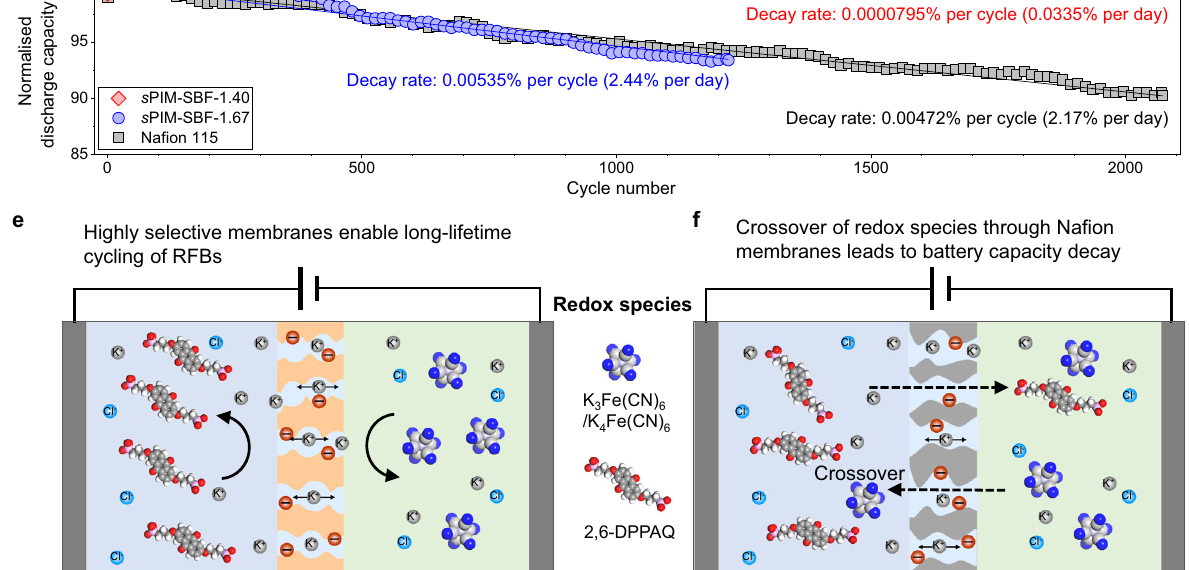
Fig. 4 Low-concentration redox fl ow battery performance. a EIS spectra of K 4 Fe(CN) 6 (0.1 M)|2,6-DPPAQ (0.1 M) fl ow battery cells at 100% SOC. b Energy ef fi ciency as a function of current density in the range of 10 – 100 mA cm − 2 . Membrane thicknesses are 142 µ m (Na fi on 115), 176 µ m ( s PIM-SBF- 1.86), 45 µ m ( s PIM-SBF-1.67a), 177 µ m ( s PIM-SBF-1.67b), 134 µ m ( s PIM-SBF-1.40) and 139 µ m ( s PIM-SBF-0.98), respectively. c Voltage and power density versus current density at ~100% SOC. d Cycling stability of K 4 Fe(CN) 6 (0.1 M)|2,6-DPPAQ (0.1 M) RFBs assembled with s PIM-SBF-1.40 (134 µ m), s PIM- SBF-1.67 (177 µ m) and Na fi on 115 membranes at pH 9 and a current density of 100 mA cm − 2 . Normalized discharge capacity data are linearly fi tted to derive capacity decay rates. The operating temperature in the glovebox is around 30 °C. Schematic illustrating the crossover mechanism that dominates battery capacity decay based on e , s PIM-SBF membranes and f , Na fi on 115